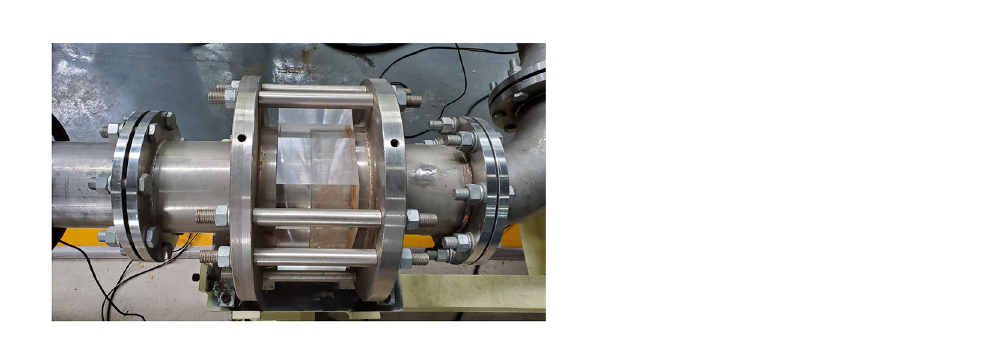
Figure 1. Test prototype of the multiphase pump.